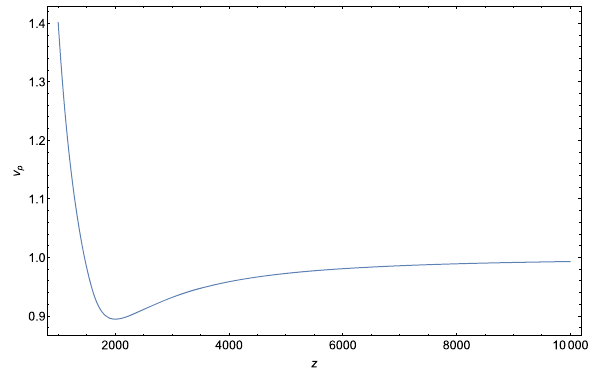
Fig. 4 Phase velocity v p vs redshift z